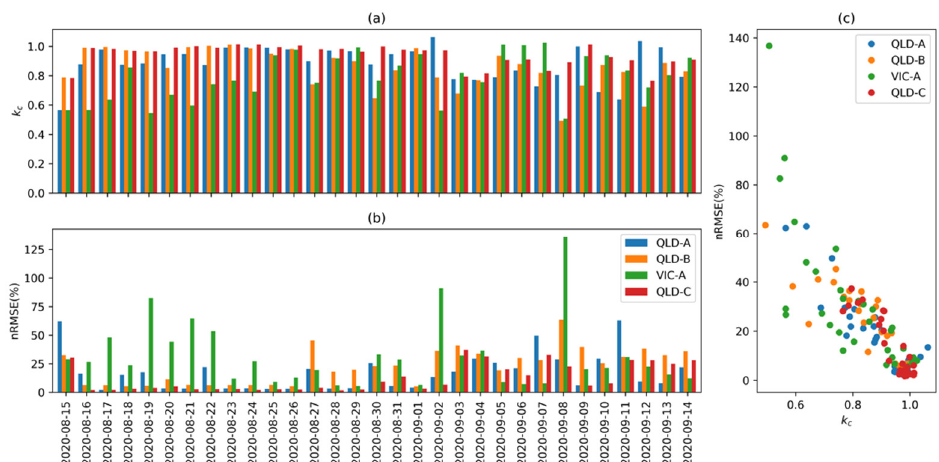
Figure 5. Daily evaluations of modelled GHI and cloudiness in the benchmarking period for: ( a ) mean clear sky index; ( b ) nRMSE; ( c ) relationship between daily clearness and errors in deriving GHI.